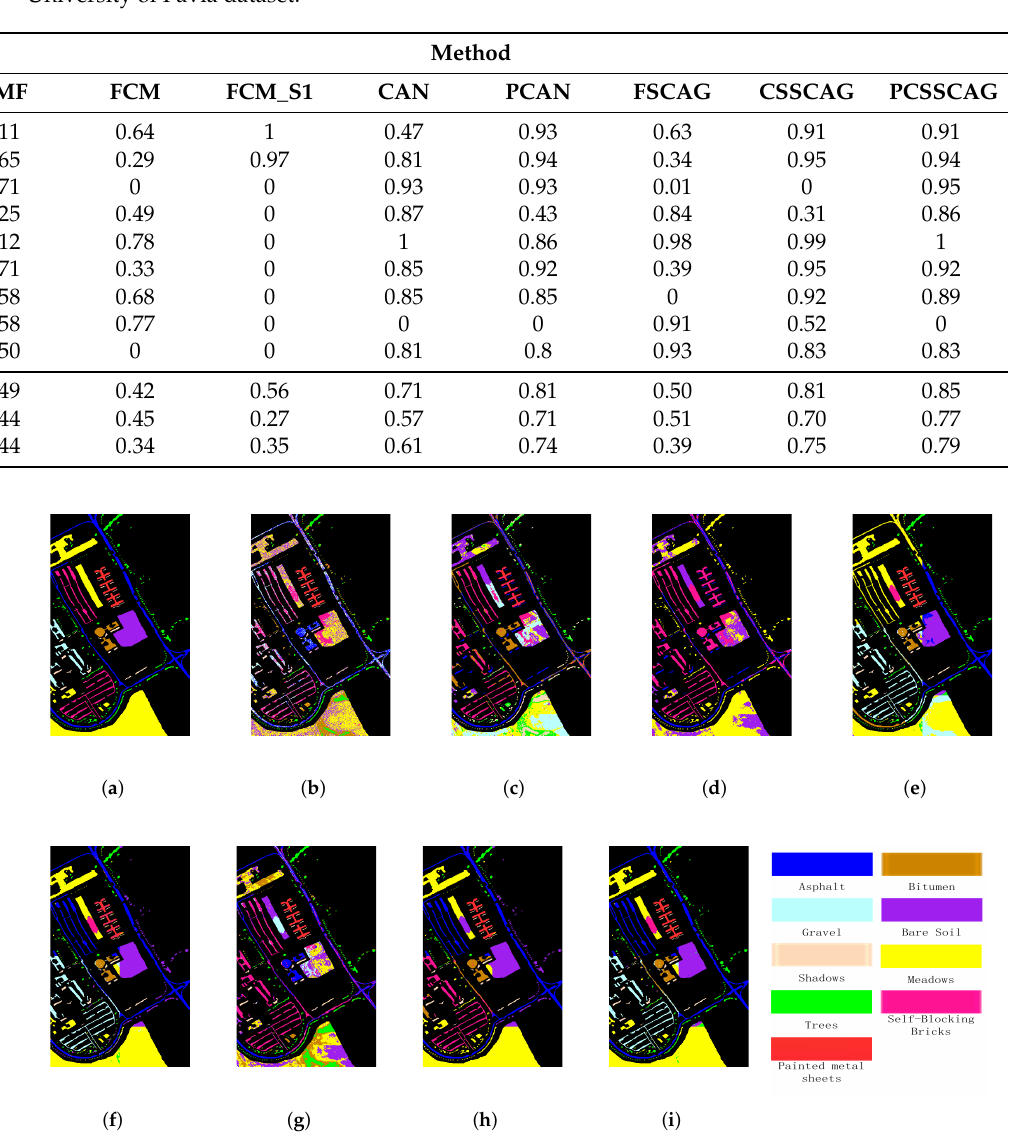
Figure 9. Cluster maps of different methods for the University of Pavia dataset. ( a ) Ground